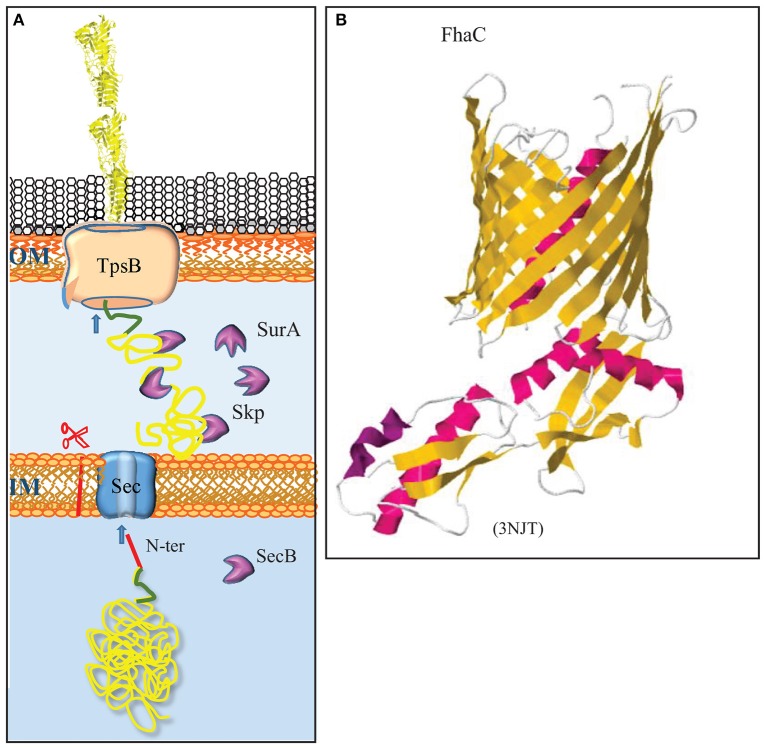
The two-partner secretion system. (A) The TpsA substrates contain a cleavable signal sequence (red) for Sec-mediated translocation across the inner membrane (IM). After chaperone-escorted transit of the periplasm, the N-terminal TPS domain (green) interacts with the integral OMP TpsB, which mediates transport across the outer membrane (OM). (B) Structure of the TpsB FhaC of B. pertussis (Clantin et al., 2007). TpsB consists of a β-barrel domain embedded in the OM and two periplasmic POTRA domains that interact with the TPS domain of substrates. The first POTRA domain is connected via a linker with an N-terminal α-helix that plugs the β-barrel in the resting state. The structure of the R450A mutant of FhaC is depicted to show the plugging of the channel. β-Strands and α-helices are colored yellow and red, respectively. The PDB access code is provided in brackets.